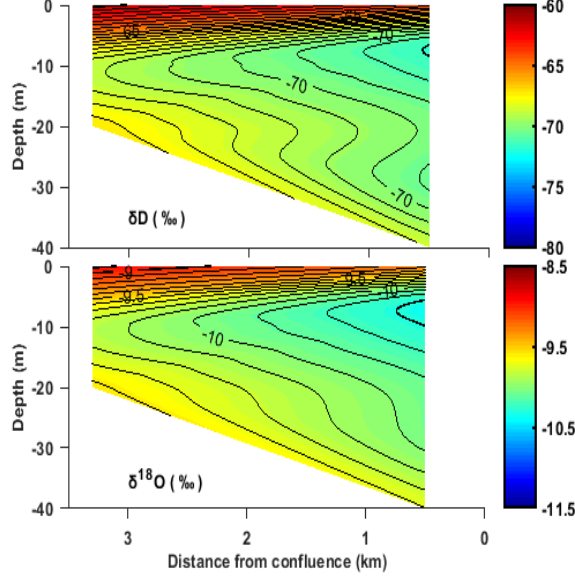
Figure 6. Spatial variation of the δ D and δ 18 O in the Zhuyi Bay in the wet season.